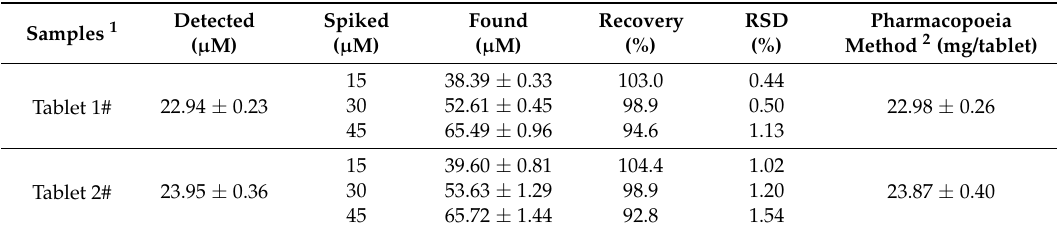
Table 2. Recovery and precision of metronidazole in tablets ( n = 6).